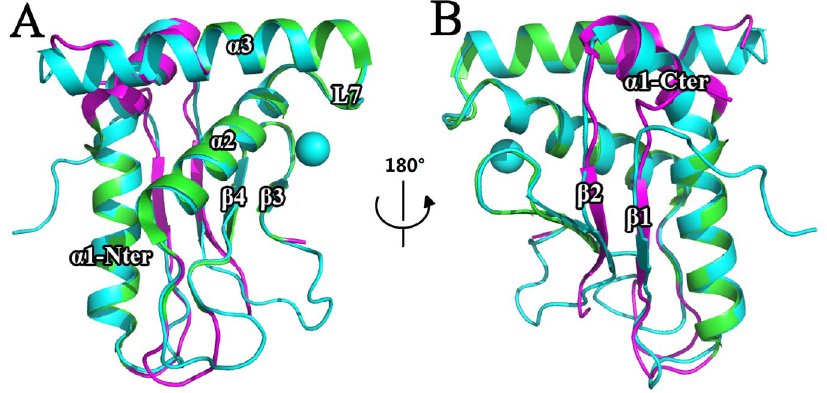
Figure 5. Tertiary structure alignment of ScWss1 21-148 (PDB: 5XBN) and SpWss1 17-151 (PDB: 5JIG). The color of ScWss1 21-148 is shown in cyan. The color of SpWss1 17-151 is shown in green for the parts which coincide well with ScWss1 21-148 , while for the parts that deviate greater from ScWss1 21-148 are colored in magenta. ( A ) The parts that coincide well between the two proteins, including α 2, α 3, β 3, β 4, loop7, and N terminal of α 1. ( B ) The parts that deviate from each other, including β 1, β 2, the C terminal of α 1, and the loops except for loop7.